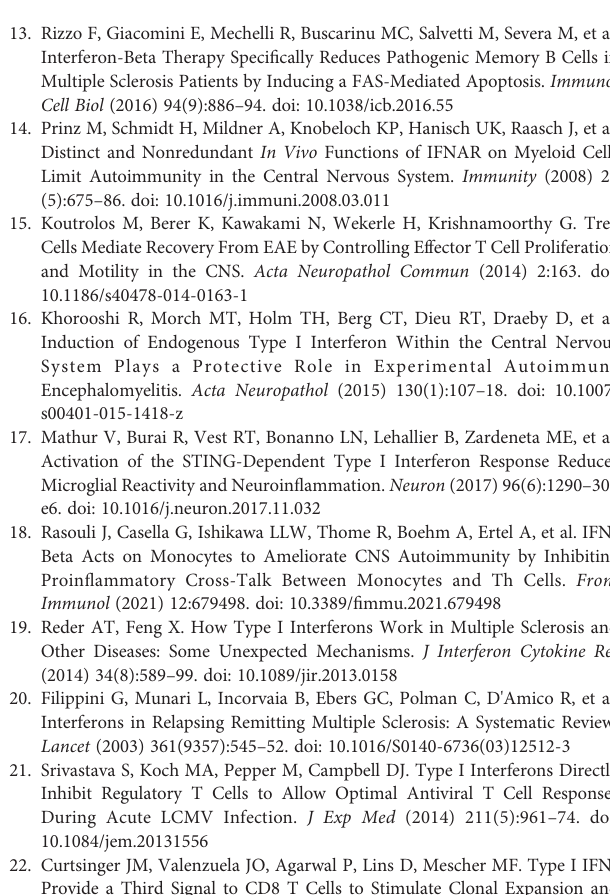
Supplementary Figure 1 | Representative plots of T cell in fi ltration into the CNS in IFNARko mice. Supplementary Figure2 | Gating strategyfor immune cellin fi ltrates tothe central nervous system. Supplementary Figure 3 | Gating strategy for Treg cells in the